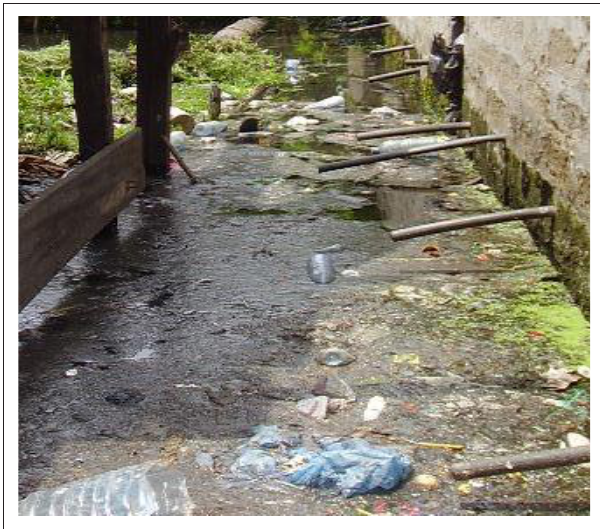
FIGURE 8 : Construction of protective walls (a) before rainfall and (b) after rainfall.